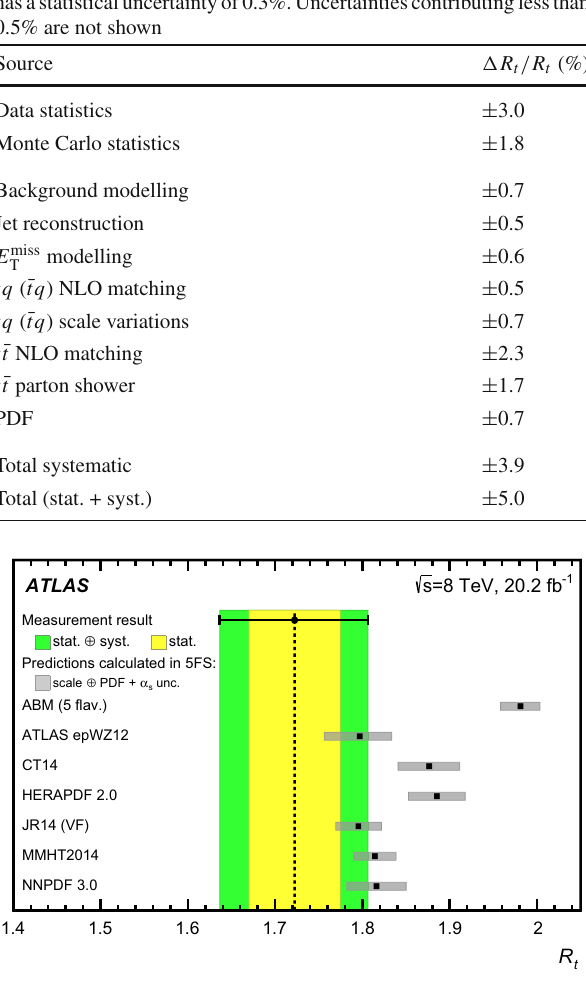
Table 5 Significant contributions to the total relative uncertainty in the measured value of R t . The estimation of the systematic uncertainties